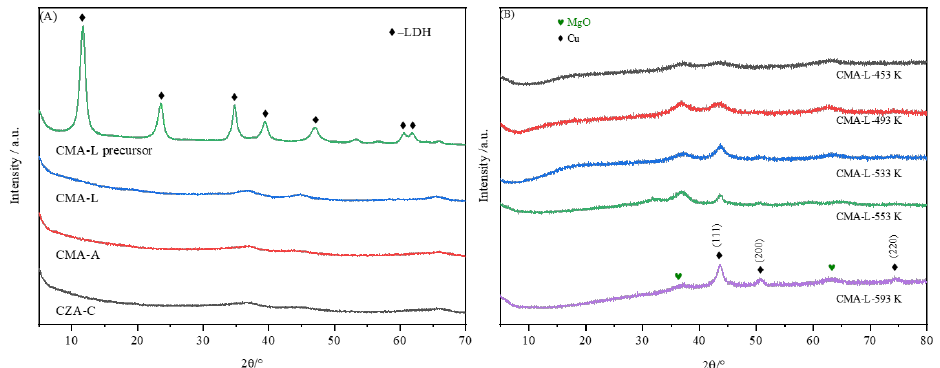
Figure 1. XRD patterns of the precursors CMA-L-LDH, and calcined samples CMA-L, CMA-A, and CZA-C ( A ). The reduced samples of CMA-L ( B ).